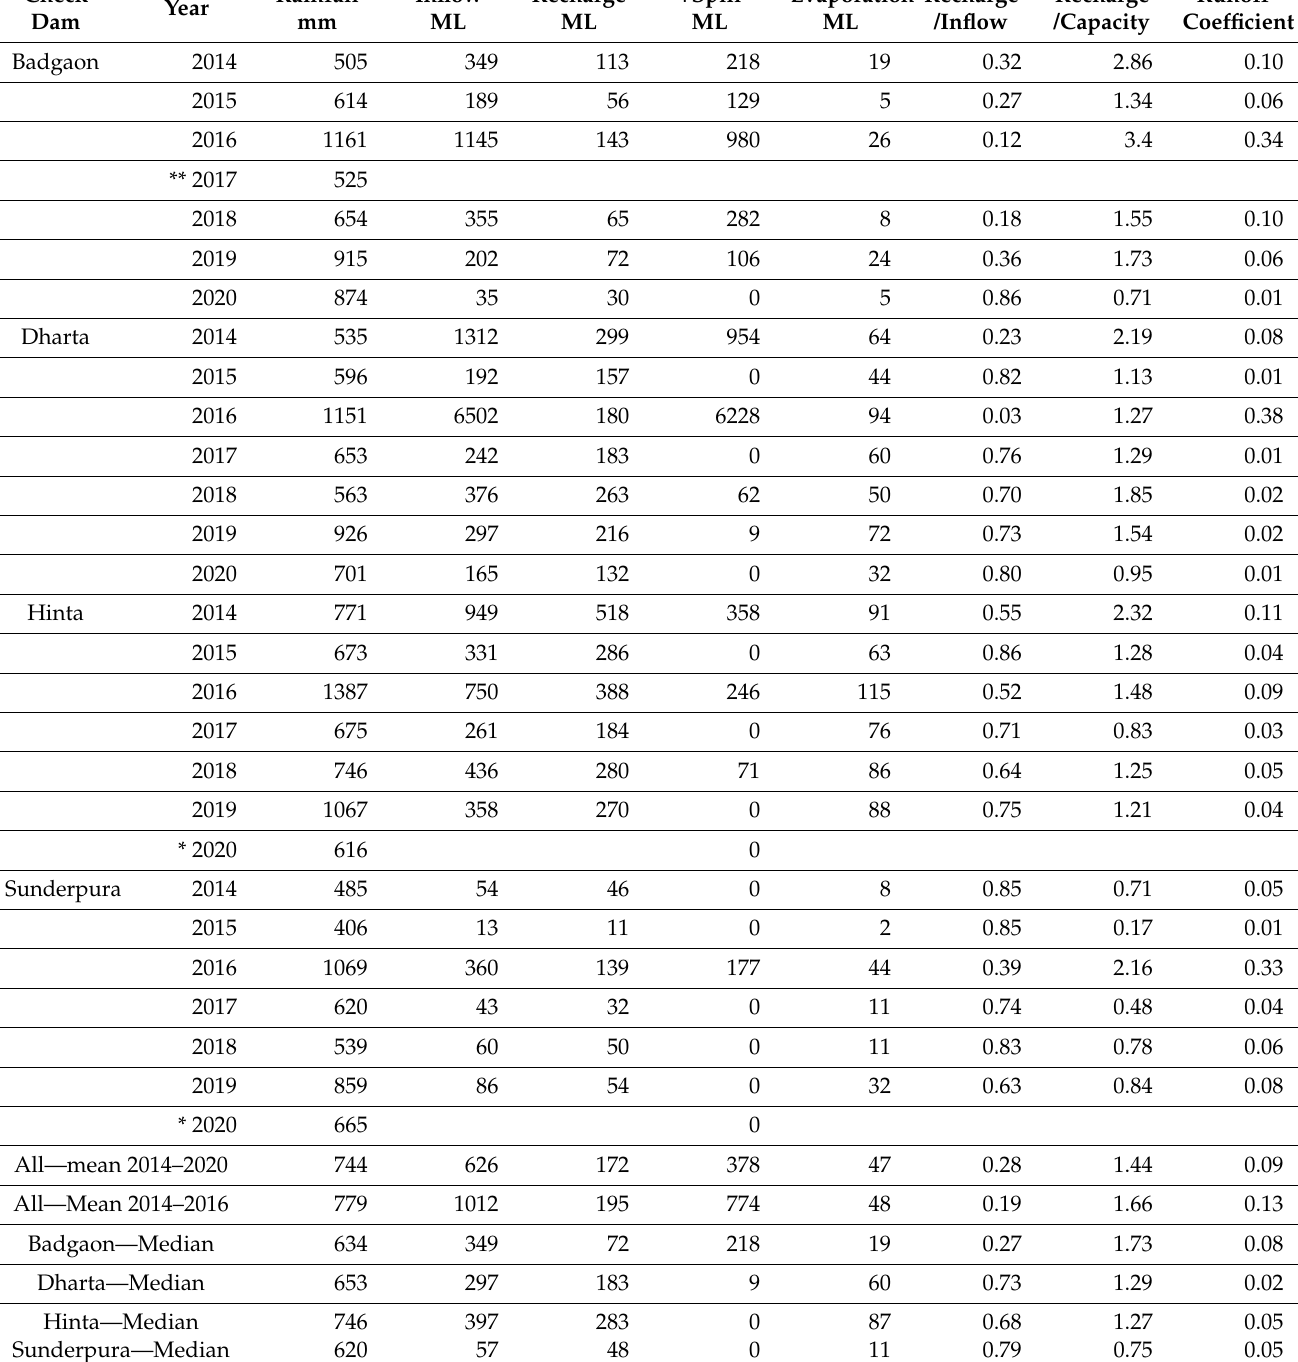
Table 3. Components of the annual water balance for four check dams (2014–2020) (1 ML = 10 3 m 3